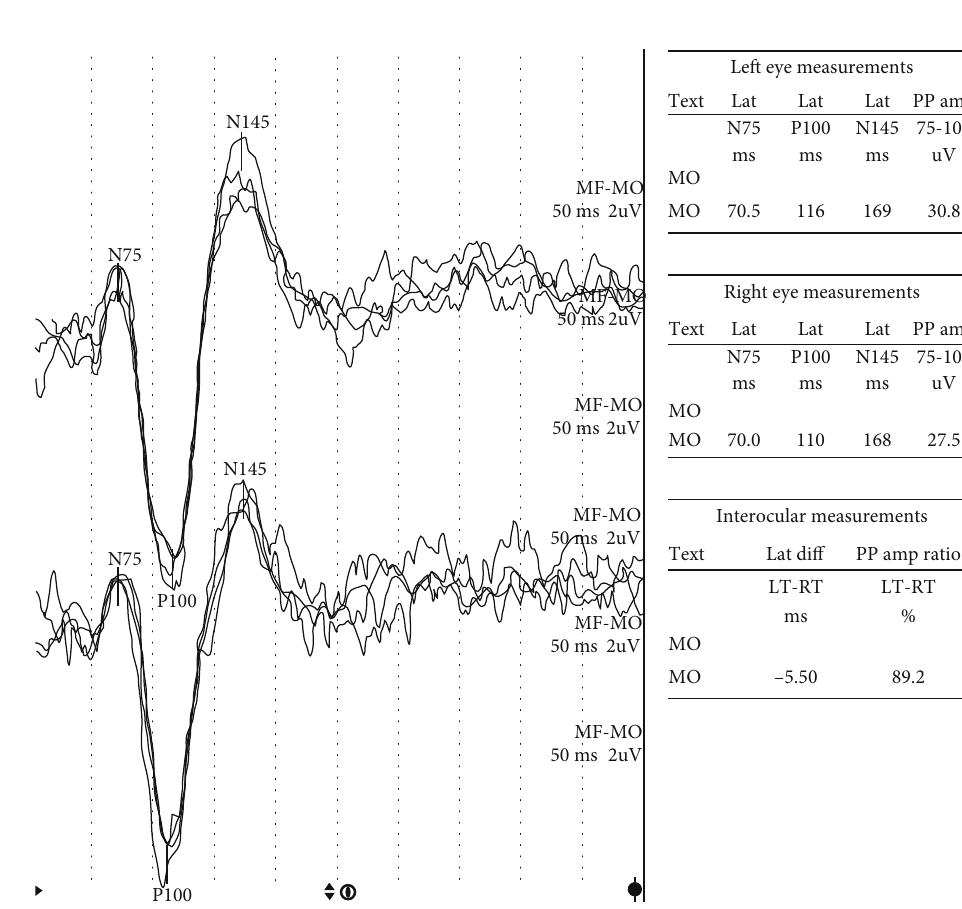
Figure 1: VEP in HT female — very high P100/N145 amplitude (L-30,8 μ V, R-27,5 μ